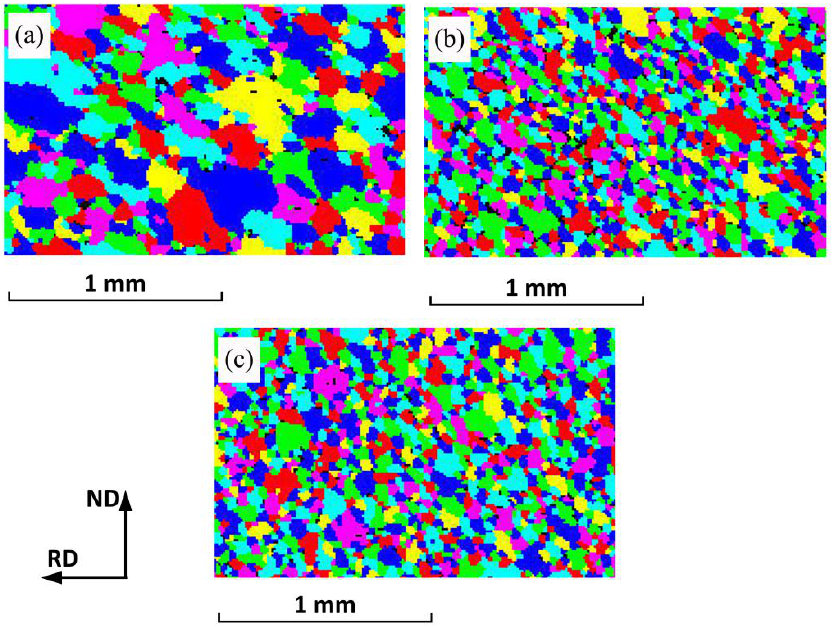
Figure 2. EBSD analysis of the three experimental alloys before brazing, ( a ) Sample A, ( b ) Sample ( c ) Sample B, ( c ) Sample C.